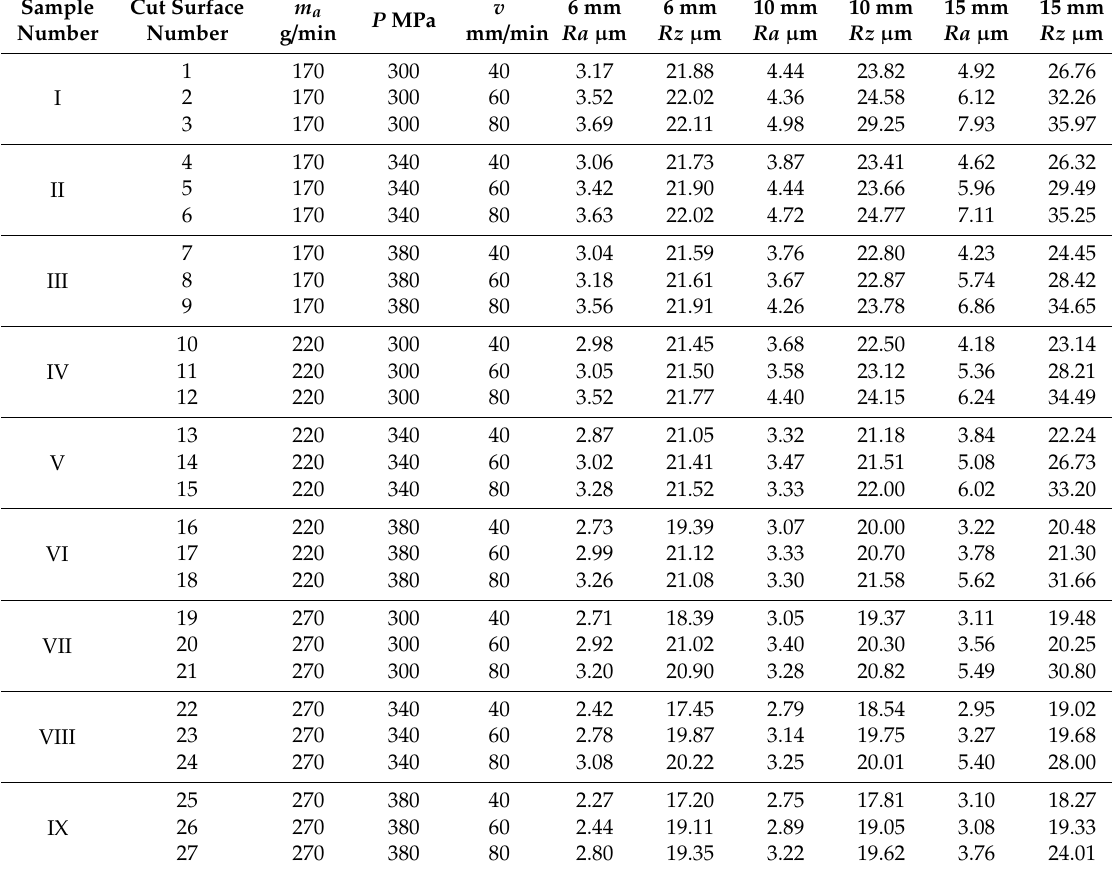
Table 3. Values of roughness Ra and Rz measured on cut surfaces of